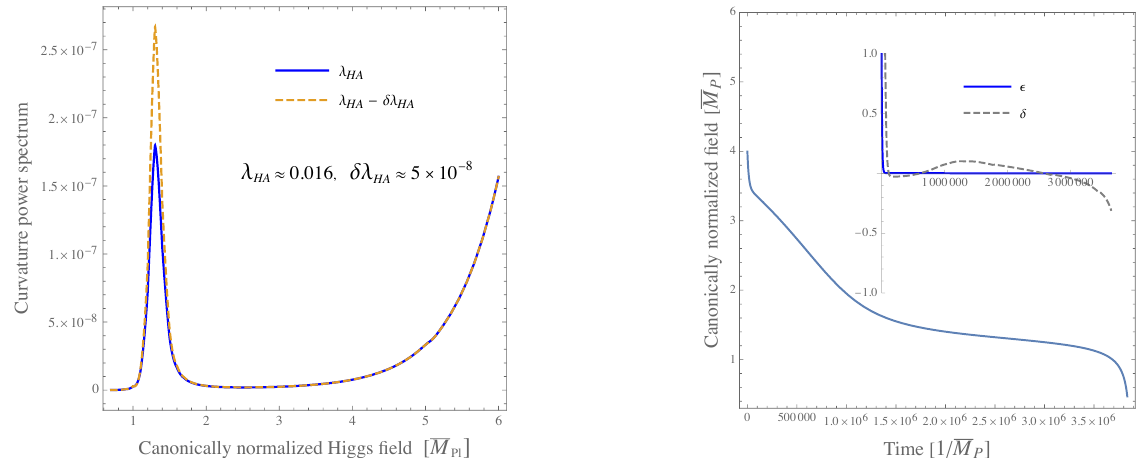
Figure 3. The curvature power spectrum and the canonically normalized (Higgs) field close to criticality (which we approach by varying λ HA ). The corresponding values of (cid:101) and δ are shown as well in an inset of the right plot. The parameters are set as in Figure